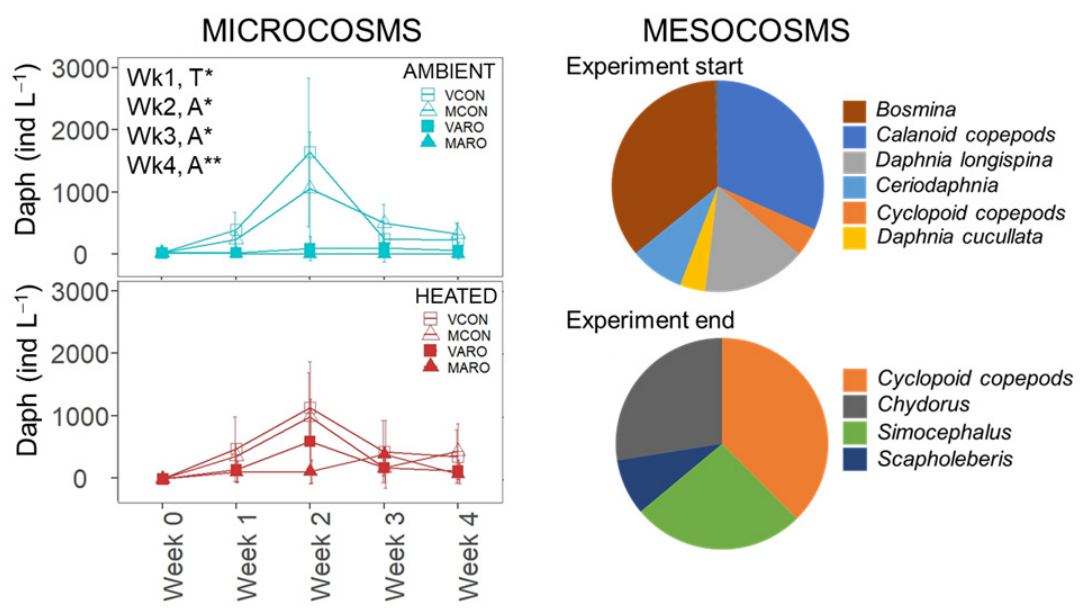
Figure 5. Impact of the stressors on the zooplankton in the microcosms ( left ) and mesocosms ( right ). In the microcosms, the temporal effects of the stressor on Daphnia numbers in the ambient (blue) and heated (red) microcosms are shown. Microcosms: VCON = Volvic control; MCON = Munich well water control. ARO; VARO = Volvic ARO; MARO = Munich well water ARO. Means ± SD, n = 5. A = ARO, T = Temperature and Wk = week. Mesocosms: zooplankton population at the start and end of experiment, pooled from all enclosures. Daph = Daphnia . * p < 0.05; ** p < 0.01.